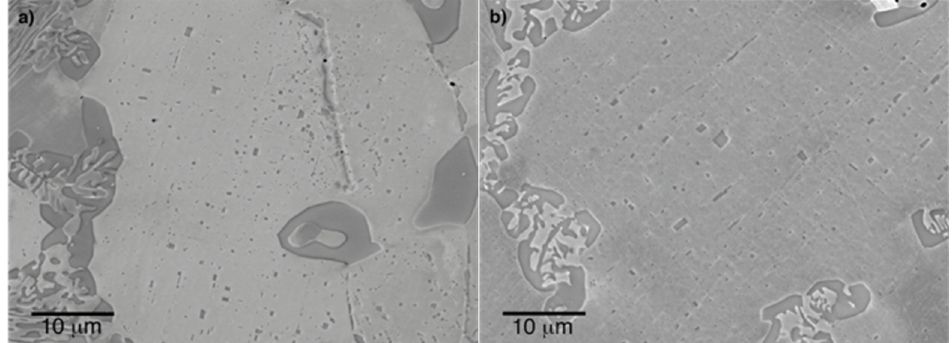
Figure 7. BSE images of the secondary carbide precipitation after oxidation testing at 1000 °C for 100 h of ( a ) as-cast and ( b ) solution heat treated Co-101 specimens.